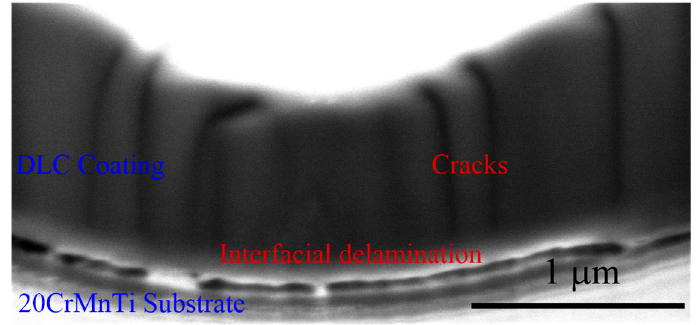
Figure 1. SEM image of a cross-section of a tested gear surface by (focused ion beam) FIB.